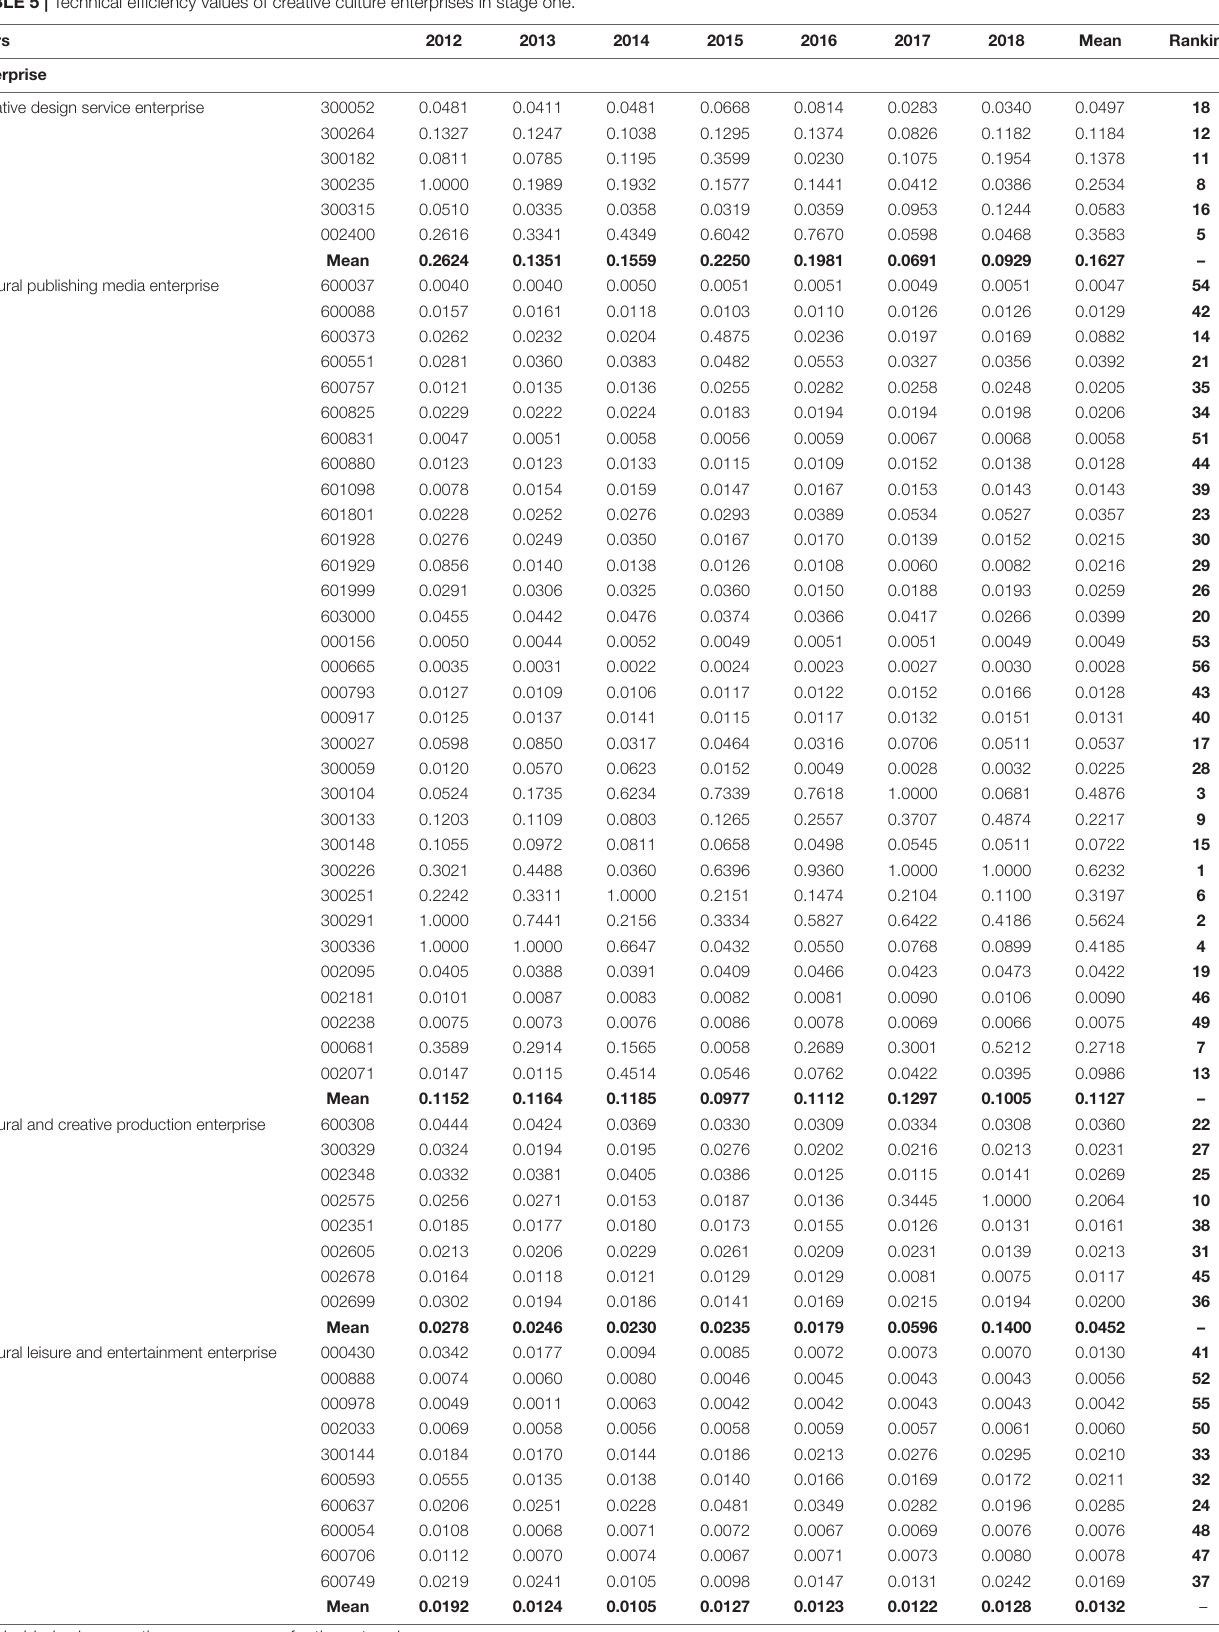
TABLE 5 | Technical efficiency values of creative culture enterprises in stage